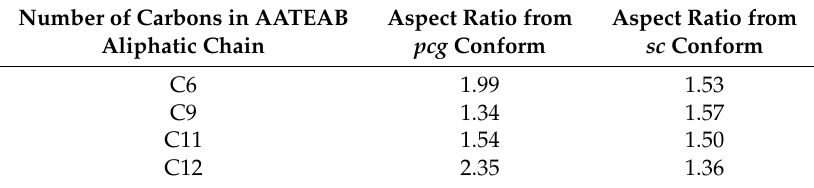
Table 2. Aspect ratios obtained from quantum/molecular mechanics (QM/MM) optimized structures and initial conforms from pcg and sc ,